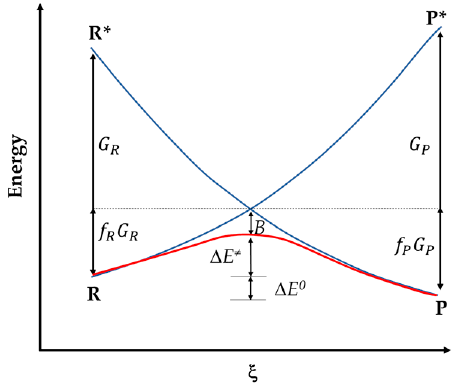
Scheme 3. Schematic valence bond state correlation diagram (VBSCD) showing the key factors that affect the